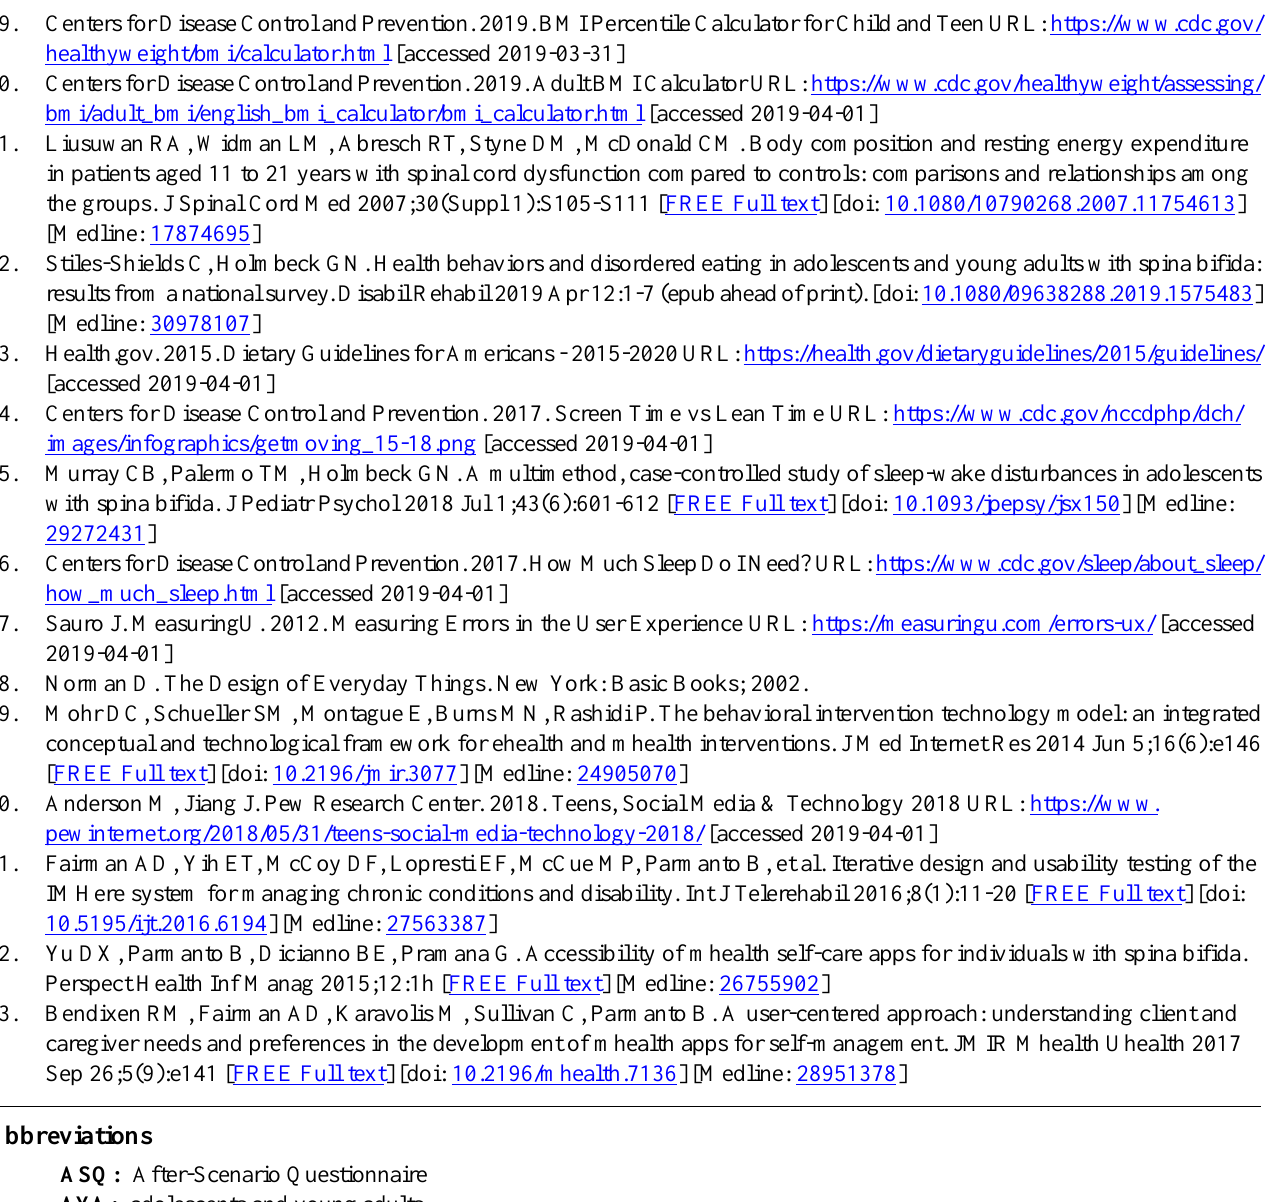
ASQ: After-Scenario Questionnaire AYA: adolescents and young adults AYA-SB: adolescents and young adults with spina bifida BIT: behavioral intervention technology BMI: body mass index CDC: Centers for Disease Control and Prevention FSIQ: Full Scale Intelligence Quotient SB: spina bifida SUS: System Usability